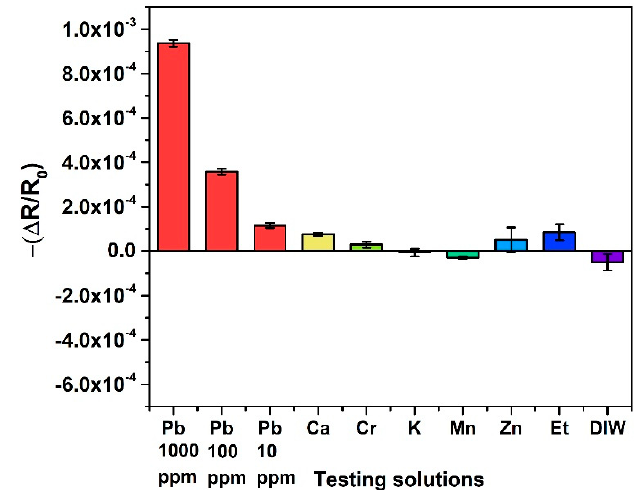
Figure 4. Sensor responses in relative resistance change to the target Pb 2 + solutions (1000 ppm; 100 ppm; 10 ppm of Pb(NO 3 ) 2 ) relative to other 1000 ppm of testing solutions of interference ions as well as pure ethanol and deionized water.